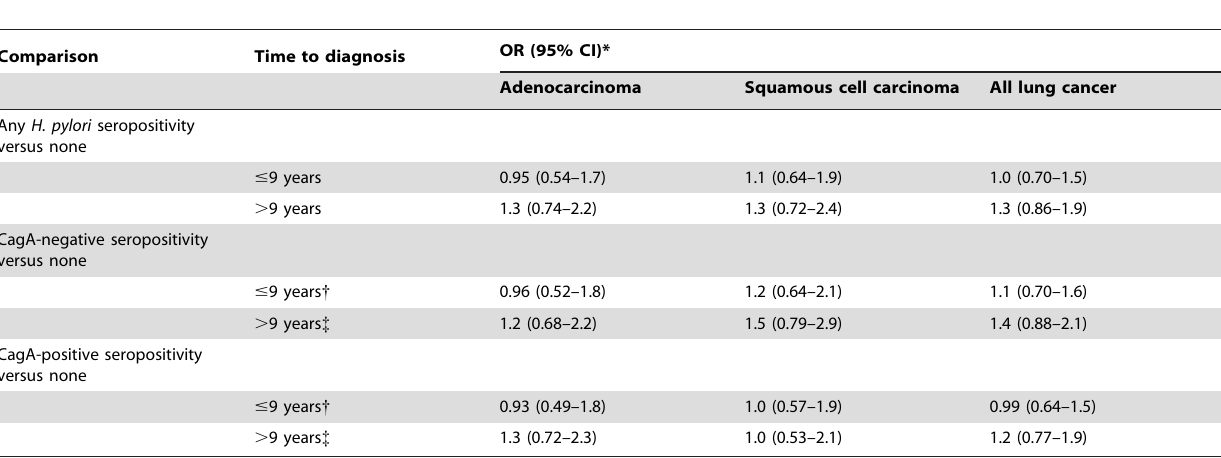
Table 3. Association of Helicobacter pylori ( H. pylori ) seropositivity with risk of lung adenocarcinoma and squamous cell carcinoma by time to diagnosis in the Alpha-Tocopherol, Beta-Carotene Cancer Prevention